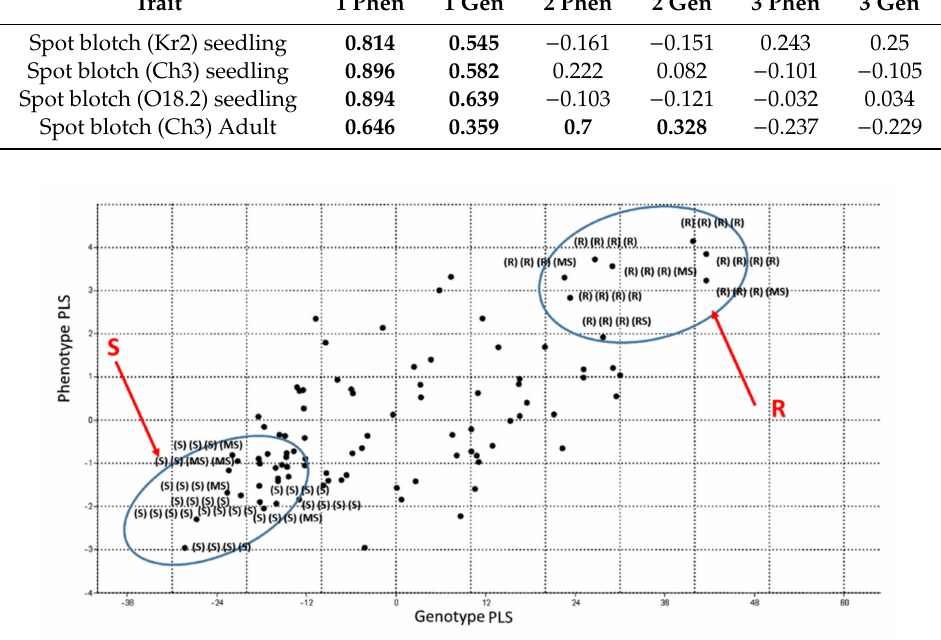
Figure 2. Correlation between genotype and phenotype data. Black points are investigated varieties. The letter in brackets means the type of resistance to one isolate for seedling and adult plants. The resistant varieties were Biom, G-21219, Omsky golozyorny 2, Svetik, Severny, Barkhatny, Kolchan, and B-1; the susceptible varieties were Abyssinia, Alag-Erdene, Arna, Avalon, Golozyorny 1,